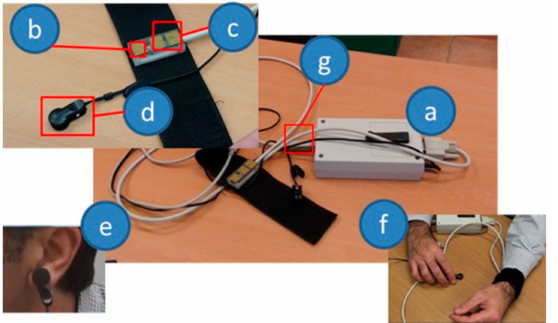
Figure 1. The biofeedback device. ( a ) Device, ( b ) Skin temperature, ( c ) GSR, ( d ) Heart rate ear clip, ( e ) User connected to heart rate ear clip, ( f ) user wearing bracelet with skin temperature and GSR sensor, ( g ) USB